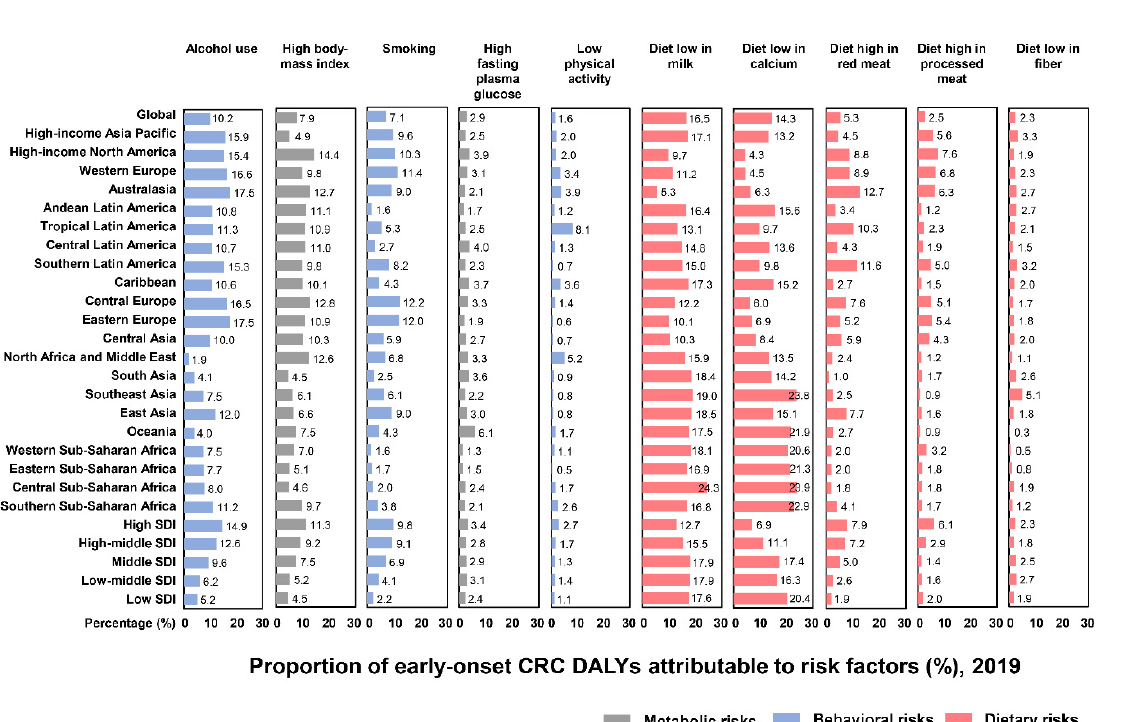
Figure 5. The proportion of DALYs of early-onset CRC to risk factors worldwide and in 21 GBD and 5 SDI regions, 2019. CRC: colorectal cancer; DALYs: disability-adjusted life-years; GBD: Global Burden of Disease; SDI: sociodemographic index.